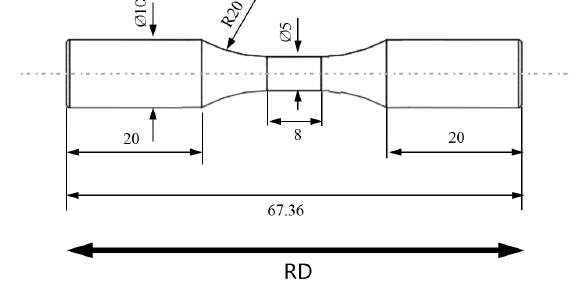
Figure 4. Geometry of smooth specimens used for low-cycle fatigue experiments (dimension in mm). Materials 2019 , 12 , x FOR PEER REVIEW